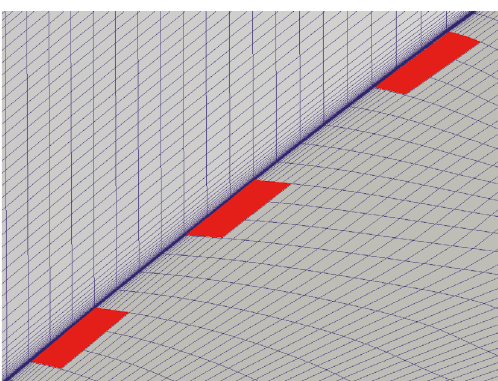
Figure 3: Numerical model of the three-slot suction effect by a boundary limit